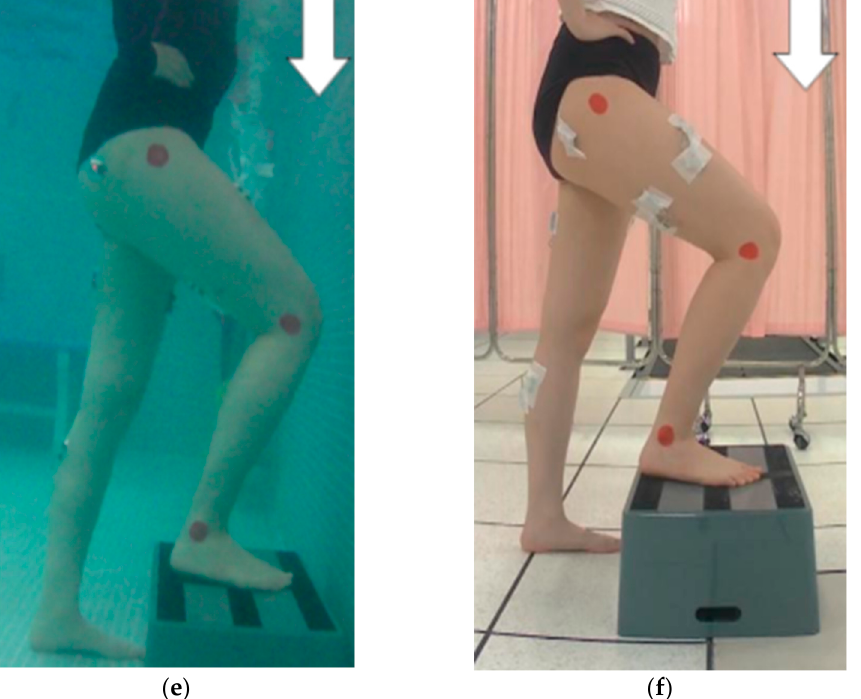
Figure 3. FSU exercise: starting position: ( a ) in water and ( b ) on land; ascending phase: ( c ) in water and ( d ) on land; descending phase: ( e ) in water and ( f ) on land.